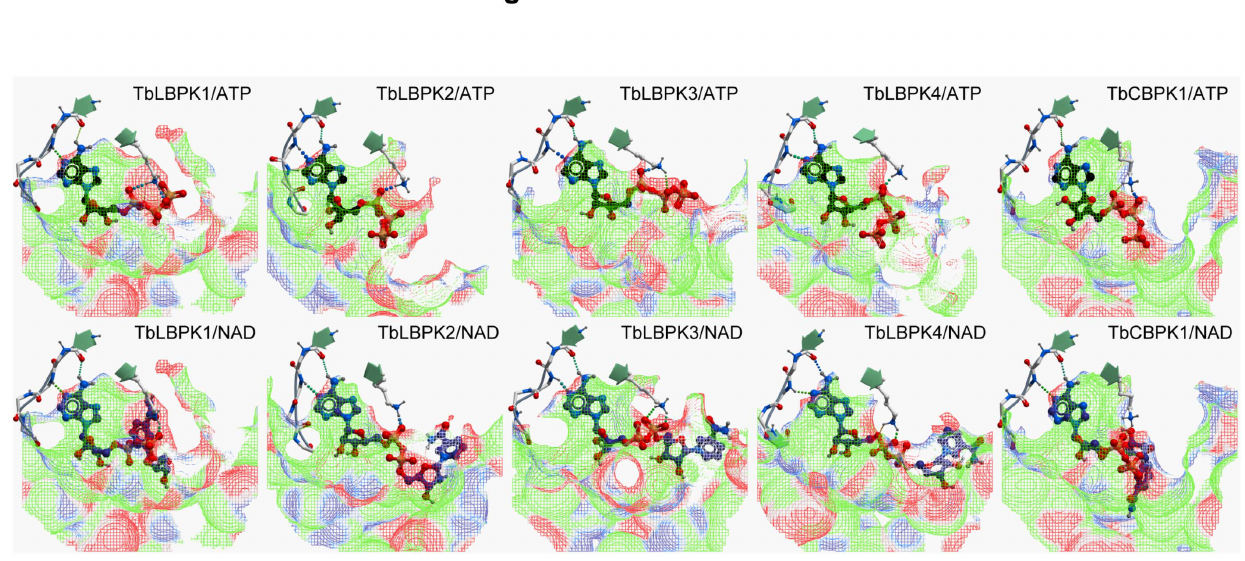
Figure 7. Docking of NAD + and ATP to homology models of TbLBPKs and TbCBPK1.